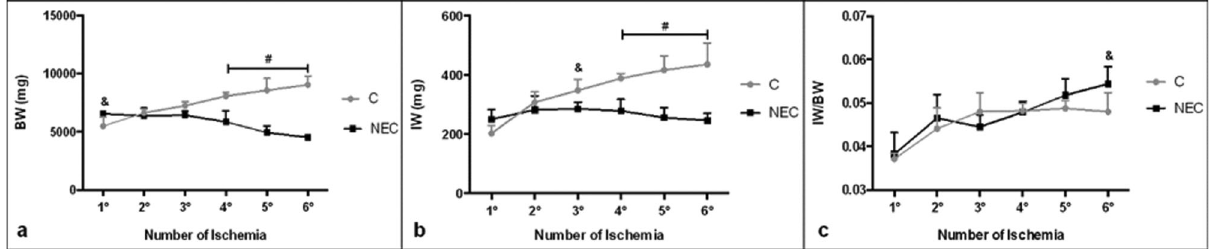
Figure 1 - Body weight and the morphological results. a) Body weight (mg); b) Intestinal weight (mg); c) Intestinal weight / Body weight ratio. Groups: control (C) and necrotizing enterocolitis (NEC). The samples were collected at the 1 st -6 th time points. & p o